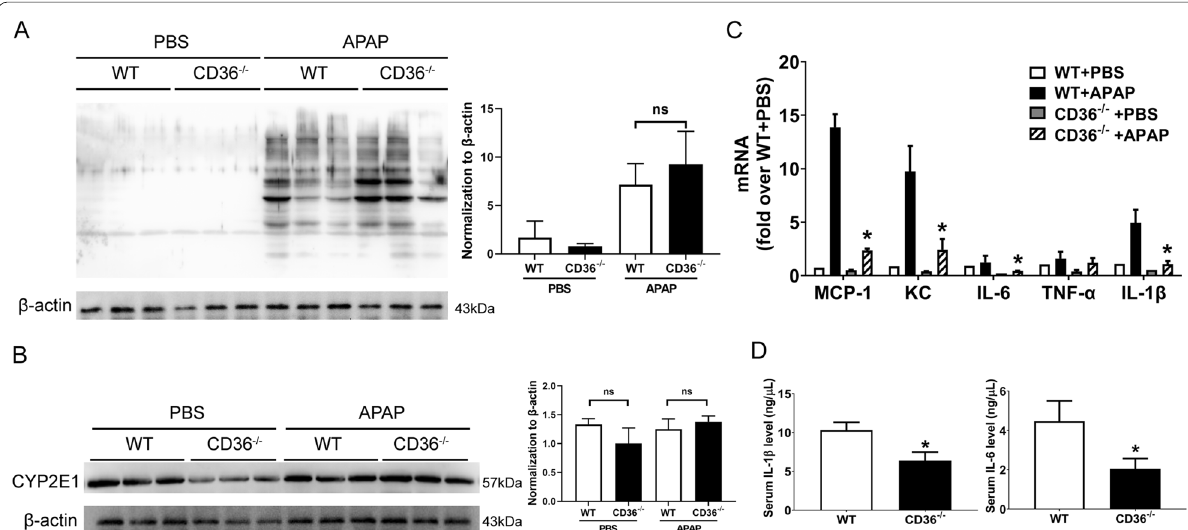
Fig. 2 Lack of CD36 ameliorated liver inflammatory responses induced by APAP. The expression of A NAPQI-protein adducts and B CYP2E1 in the liver from WT and CD36 − / − mice treated with APAP for 6 h. C mRNA level of cytokines was determined by RT-qPCR in the liver of WT and CD36 − / − mice at 24 h after APAP treatment. D Serum IL-1β and IL-6 levels in WT and CD36 − / − mice at 24 h after APAP overdosage. *P < 0.05, compared with WT mice. N 5 mice per =